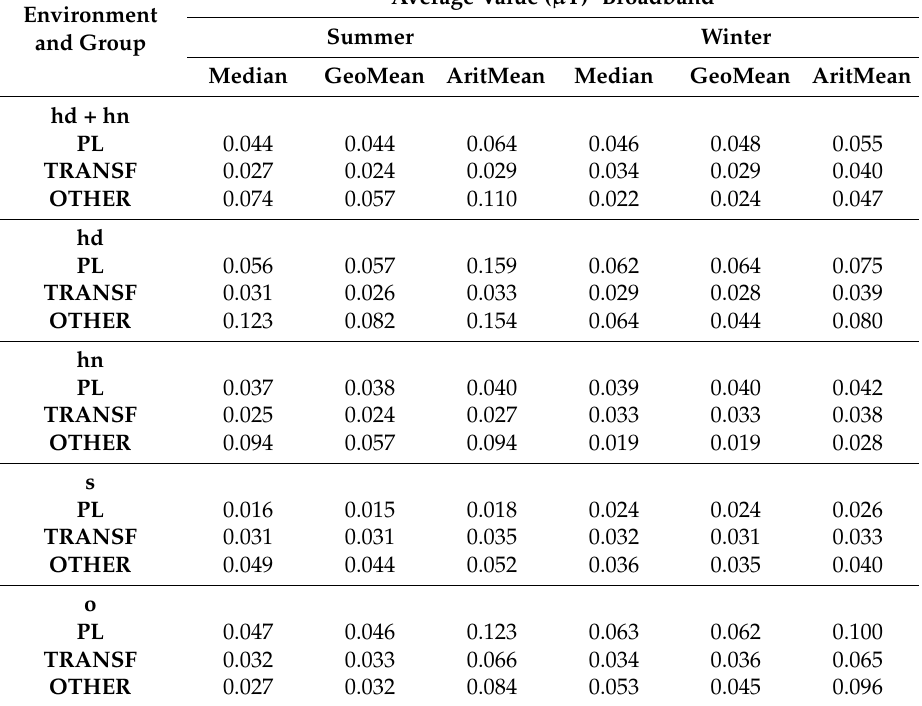
Table 5. Average value of the median, geometric mean, and arithmetic mean of personal measurements classified with respect to different environments for each group and season in the broadband frequency